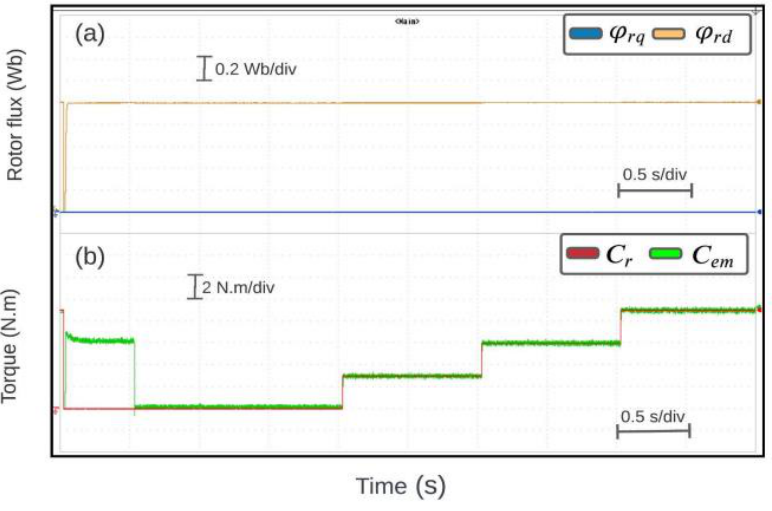
Figure 6. OeW-5PIM performance under load torque variations ( a ) d-q rotor flux responses; ( b ) developed torque.